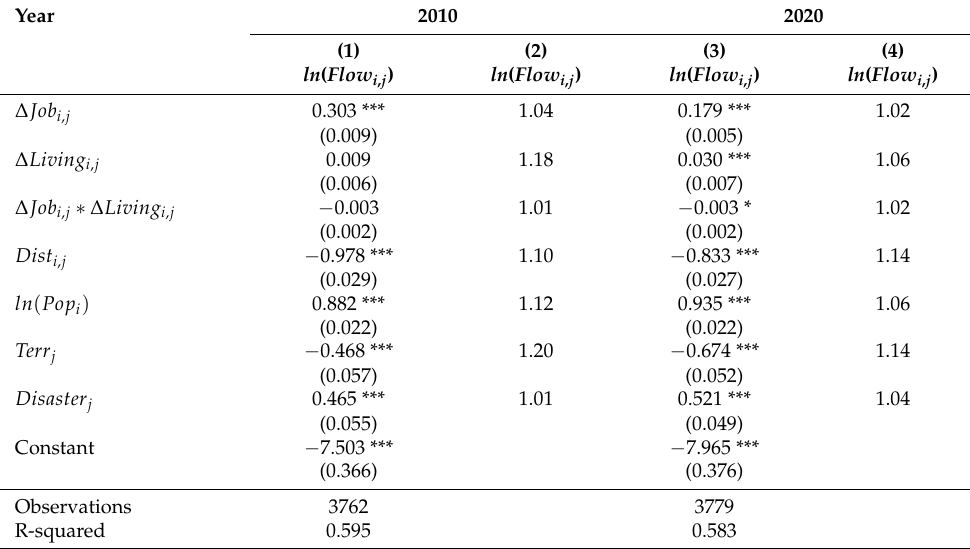
Table 4. The robust check for model (2) by adding a dummy